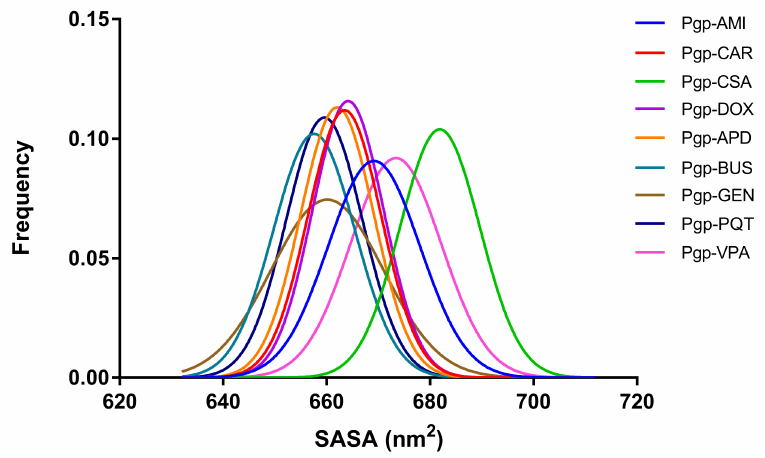
Figure 14. Distributions of the total solvent-accessible surface area (SASA) for the studied